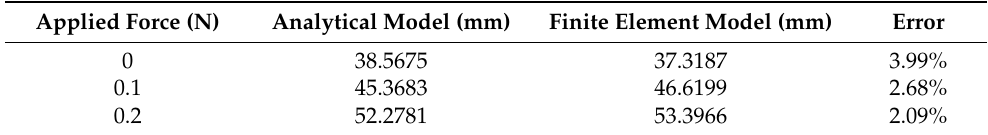
Table 2. Predicted out-of-plane deflection at the corners of the bistable plates. Applied Force (N)